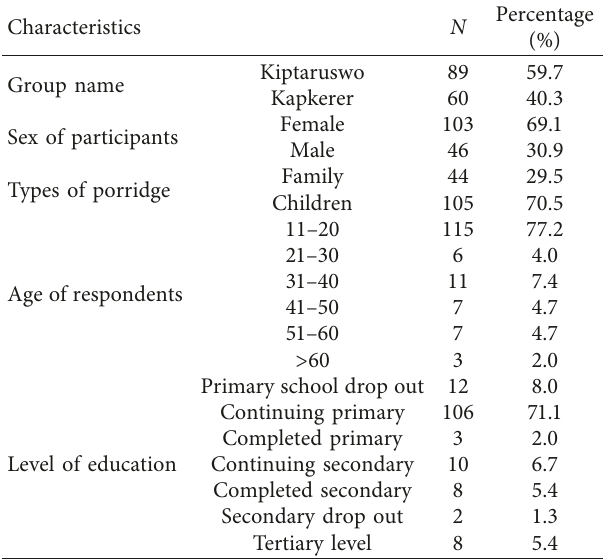
Table 2: Demographic characteristics of the study